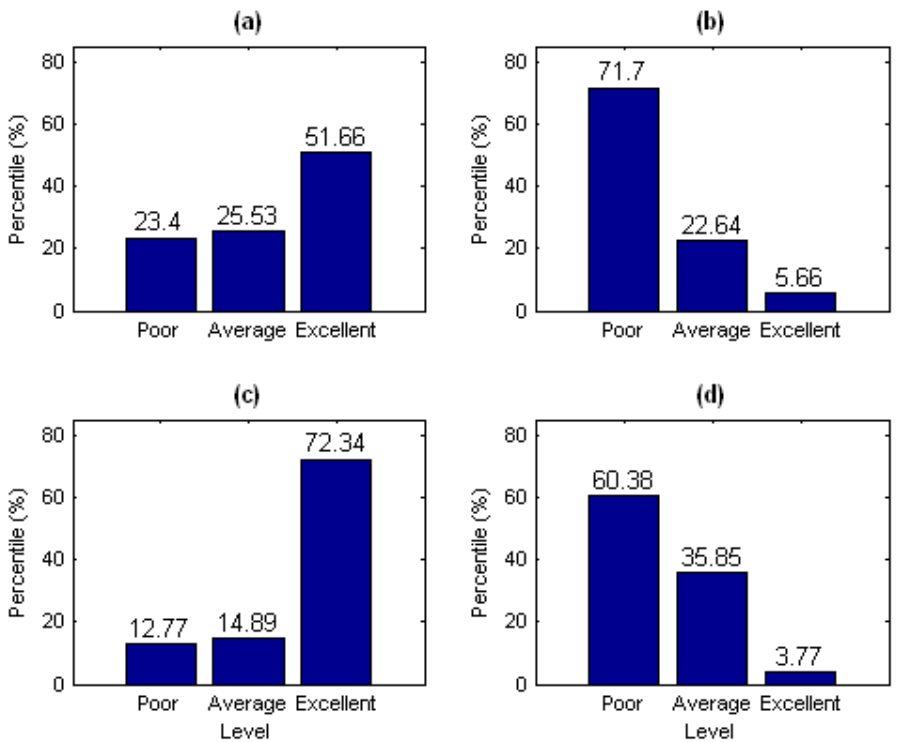
Figure 9. Percentile (%) of behavior performance levels for successful and failed collision avoidance; ( a ) device control behavior for success; ( b ) device control behavior for failure; ( c ) route control behavior for success; and ( d ) route control behavior for failure.